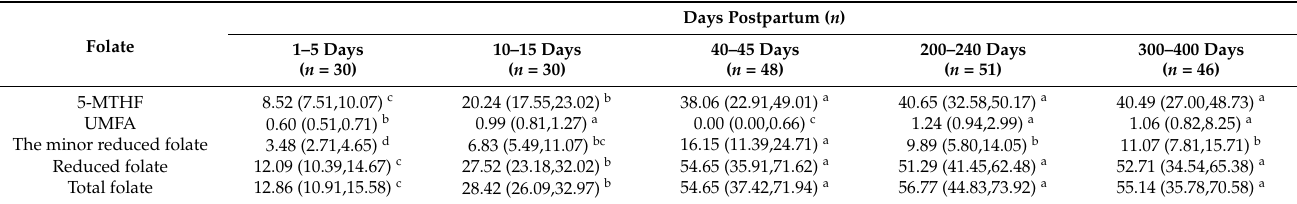
Table 2. Concentration of breast milk folate over 1–400 days postpartum (ng/mL).